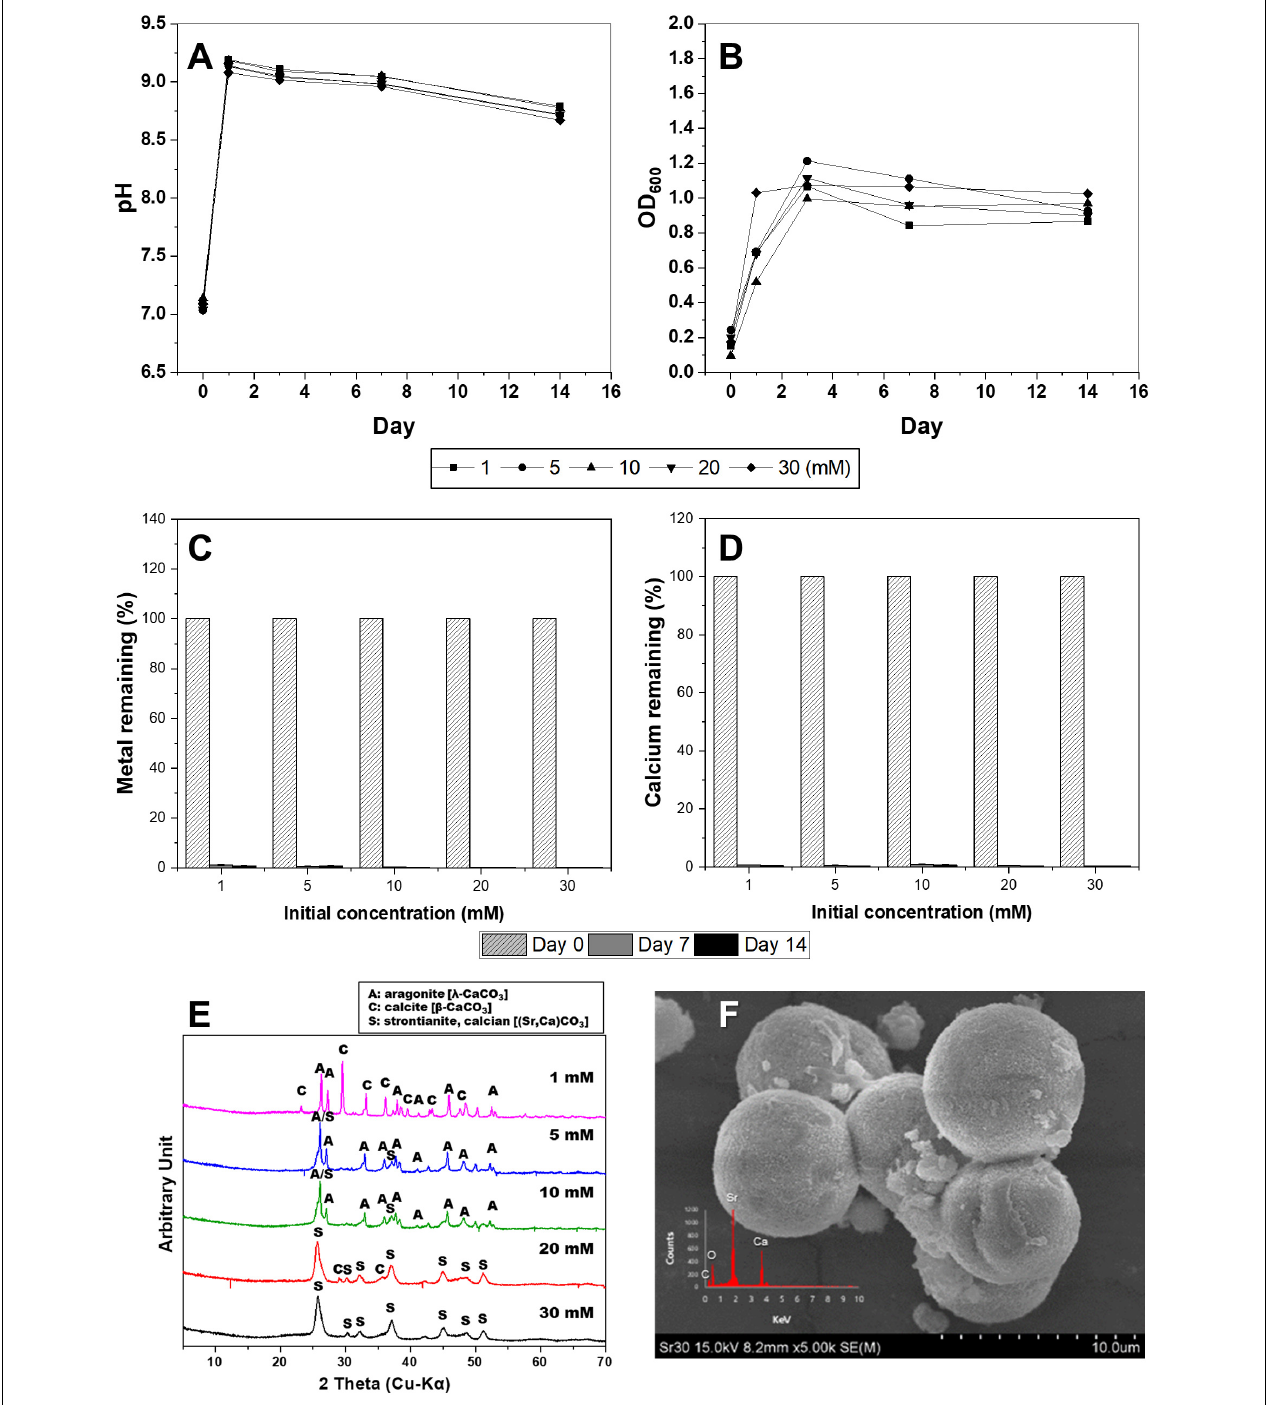
FIGURE 4 | Changes in pH value (A) , optical density (B) , concentrations of Sr (C) , and Ca (D) in KCTC 3558 culture containing various strontium concentrations (mM) for 2 weeks, and X-ray diffraction spectra (E) of precipitates at a range of Sr concentrations and scanning electron microscopy image of strontianite (F) .